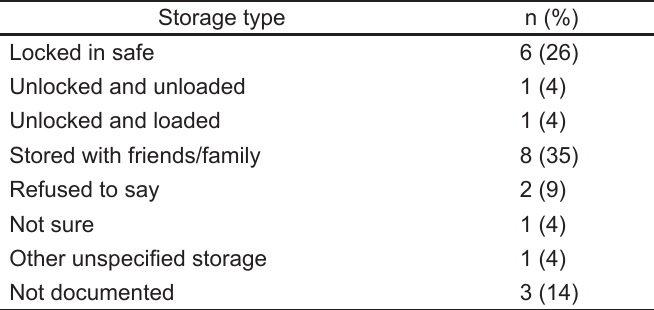
Table 2 . Firearm storage